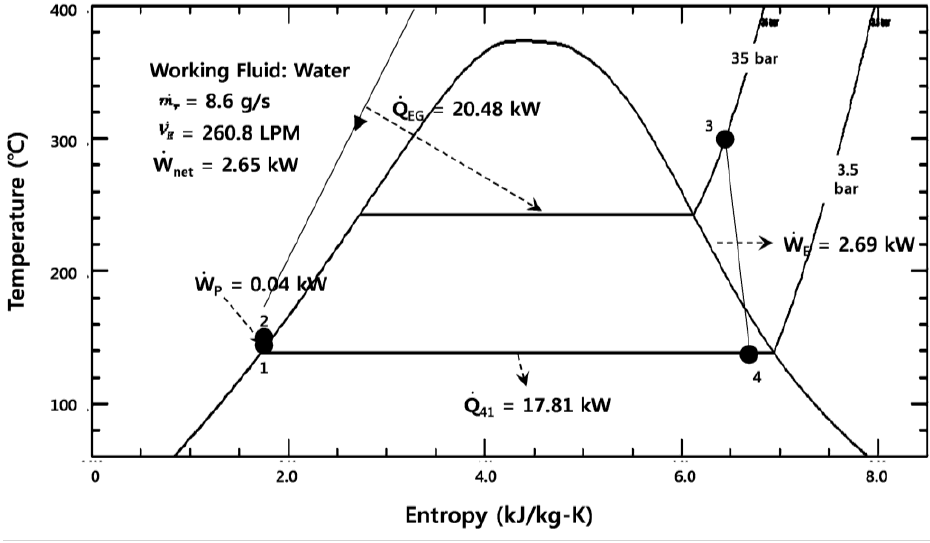
Figure 1. Temperature–entropy diagram of the high-temperature (HT)